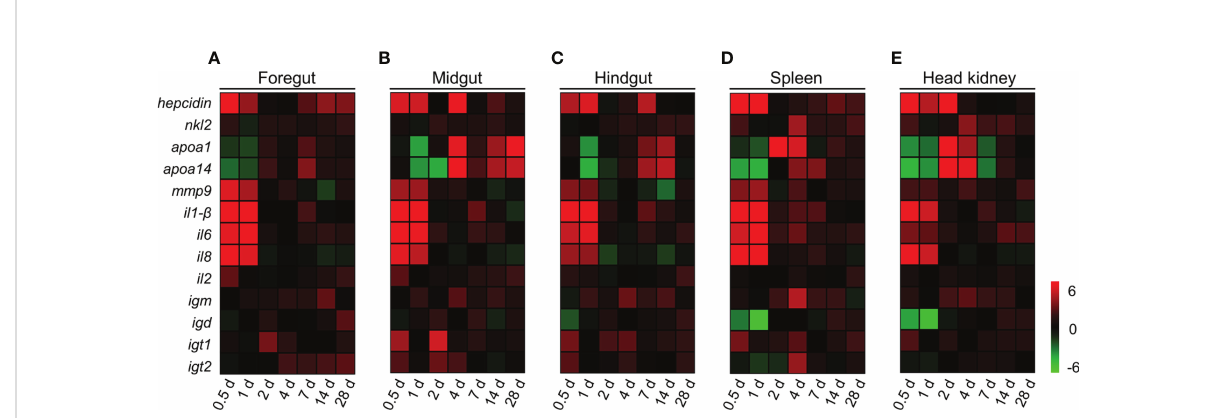
FIGURE 3 Immune response in gut, spleen, and head kidney tissues of common carp following A. hydrophila infection. (A – E) Heat map illustrates results from qPCR of mRNAs for selected immune-related genes in bacteria-challenged fi sh vs. control group measured at 0.5, 1, 2, 4, 7, 14, and 28 DPI following with A. hydrophila in the foregut (A) , midgut (B) , hindgut (C) , spleen (D) , and head kidney (E) organs of common carp ( n = 6). Color value: log 2 (fold change). Data are representative of at least three different independent